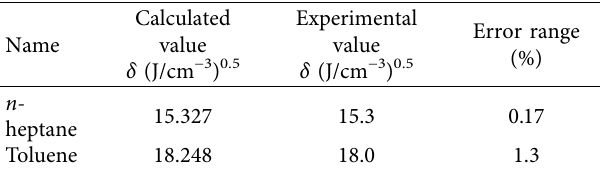
Table 2: Calculated and experimental solubility parameters at 298K.